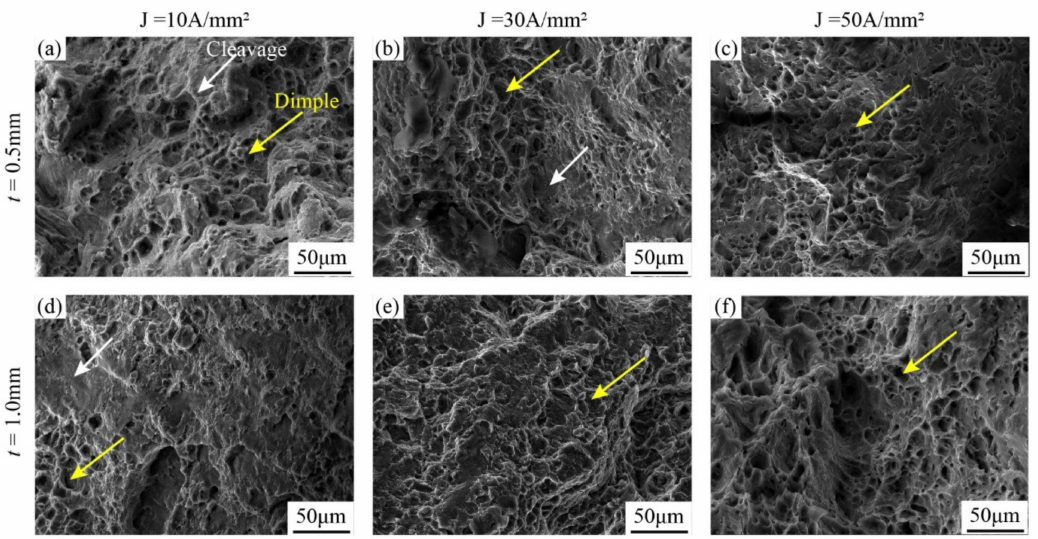
Figure 10. Fractography of the EA tensile samples under various deformation conditions of ( a ) coarse grain, t = 0.5 mm, J = 10 A/mm 2 ; ( b ) coarse grain, t = 0.5 mm, J = 30 A/mm 2 ; ( c ) coarse grain, t = 0.5 mm, J = 50 A/mm 2 ; ( d ) fine grain, t = 1.0 mm, J = 10 A/mm 2 ; ( e ) fine grain, t = 1.0 mm, J = 30 A/mm 2 ; and ( f ) fine grain, t = 1.0 mm, J = 50 A/mm 2